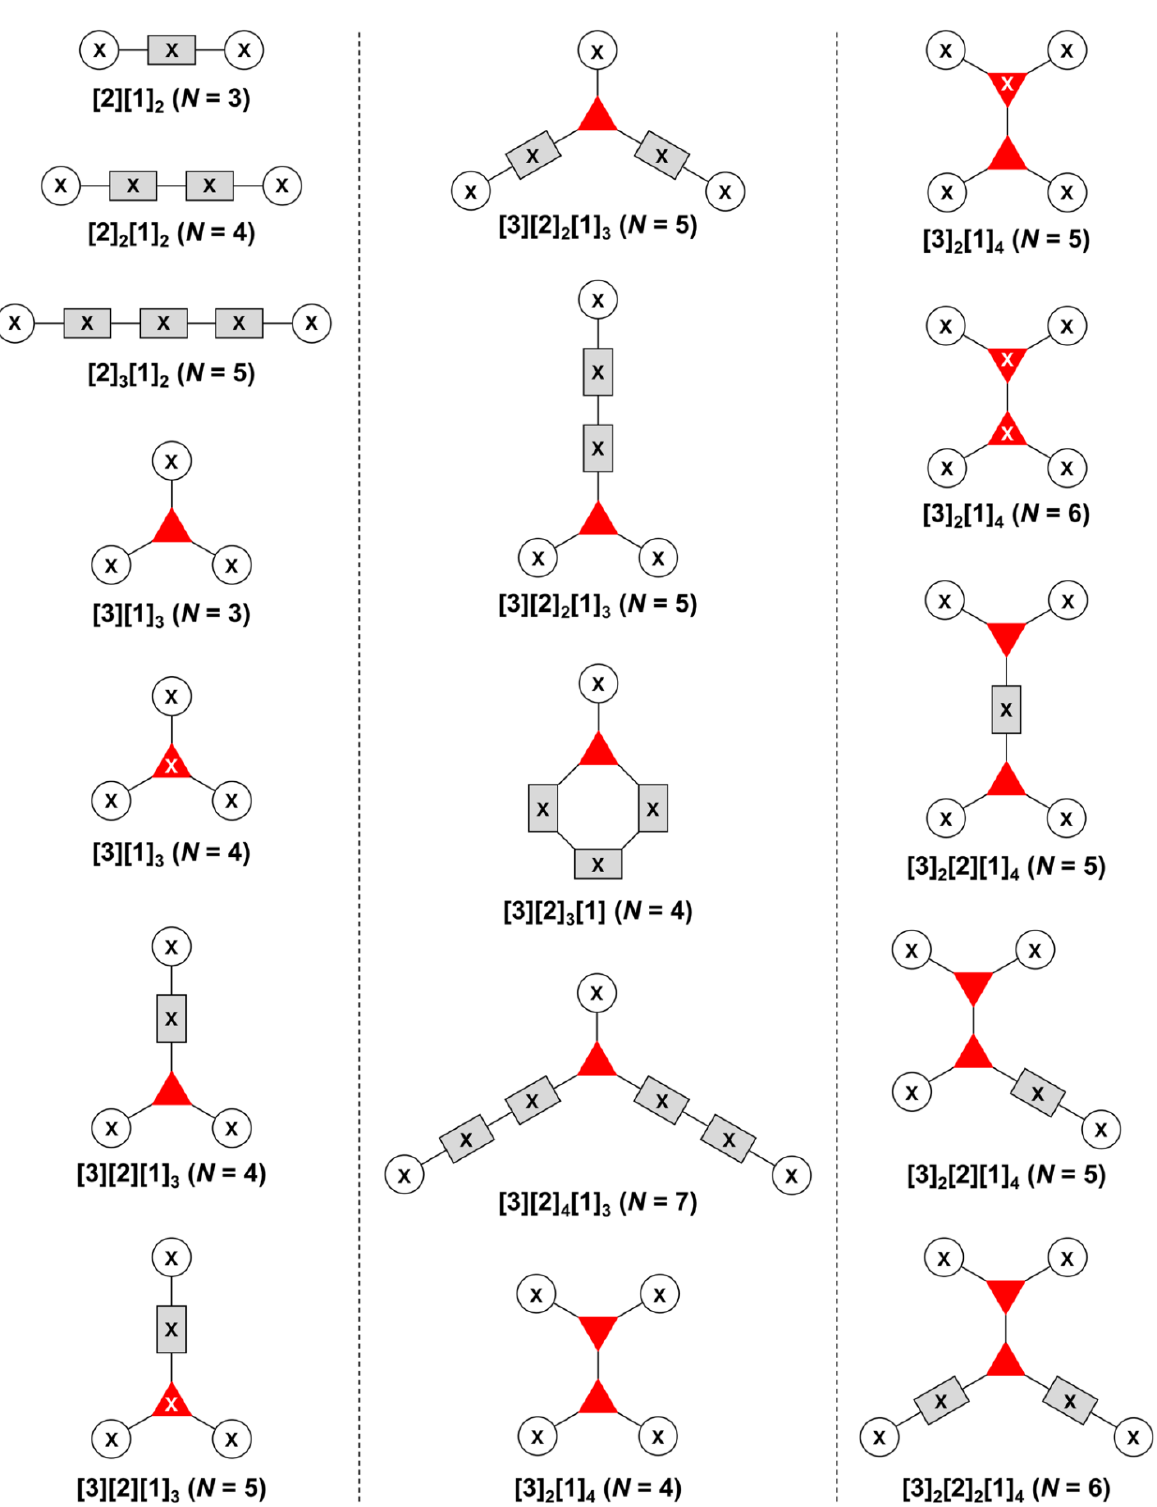
Figure 5A. When there are ≥2 hubs, counting starts at the parent hub in linear sequen- tial fashion. For a convergent synthesis step, wherein multiple identical groups be- come attached to one hub, the number of edge-forming reaction steps is tallied as proteases) can serve as reactive groups or bioactive groups, but here were included solely one. If the edge has been formed in a commercially available building block, the in the latter category. Other functionalities include water-solubilizing tags, lipid tags, and counting for the edge is labeled as “0”. An example is shown in Figure 5B, which ionic tags including, for example, a cell penetrating peptide. contains a scaffold composed of two hubs and A 3 BC